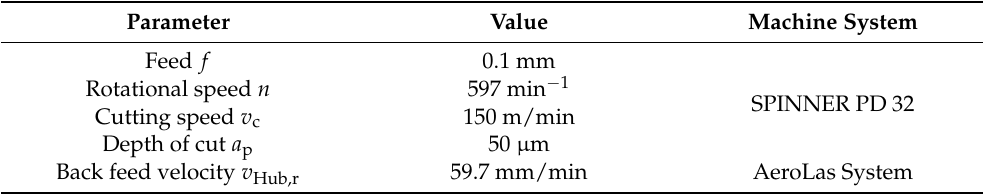
Table 2. Constant machining